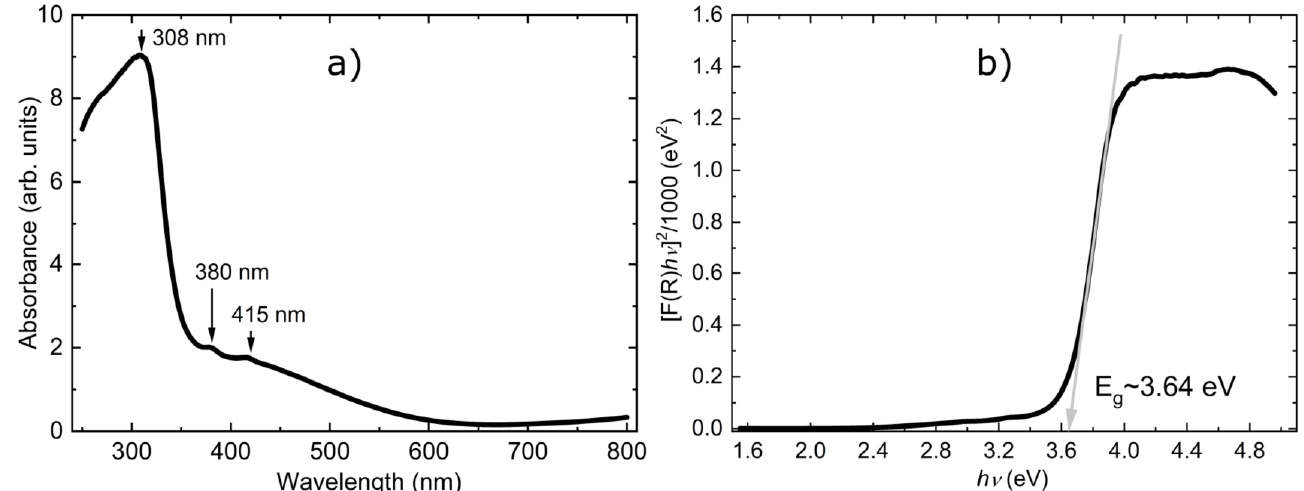
Figure 6. Panel ( a ) UV–Vis absorption spectra in the 250–800 nm range; the arrows show the three optical bands at 308, 380 and 415 nm. Panel ( b ) Tauc plot for the direct bandgap; the gray arrow shows a fitted line to the linear part of the curve; the intercept of the gray solid line with the energy axis defines the value of the band gap.